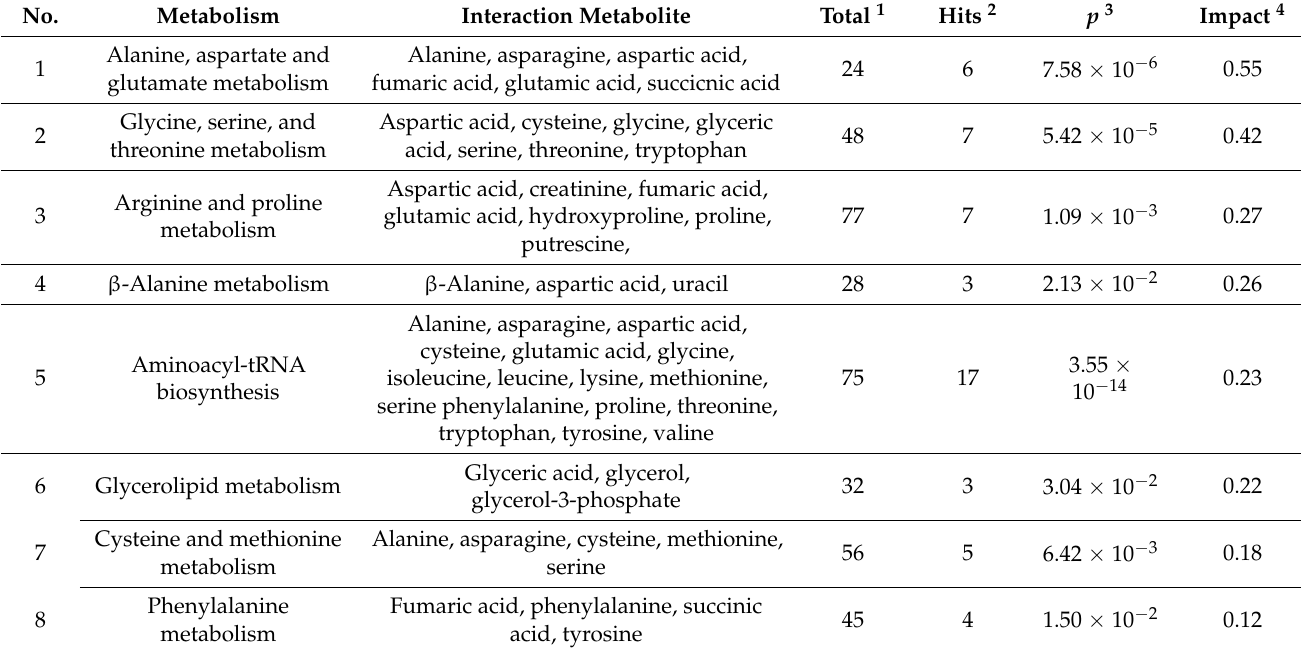
Table 1. Key metabolic pathways associated with lung squamous cell cancer